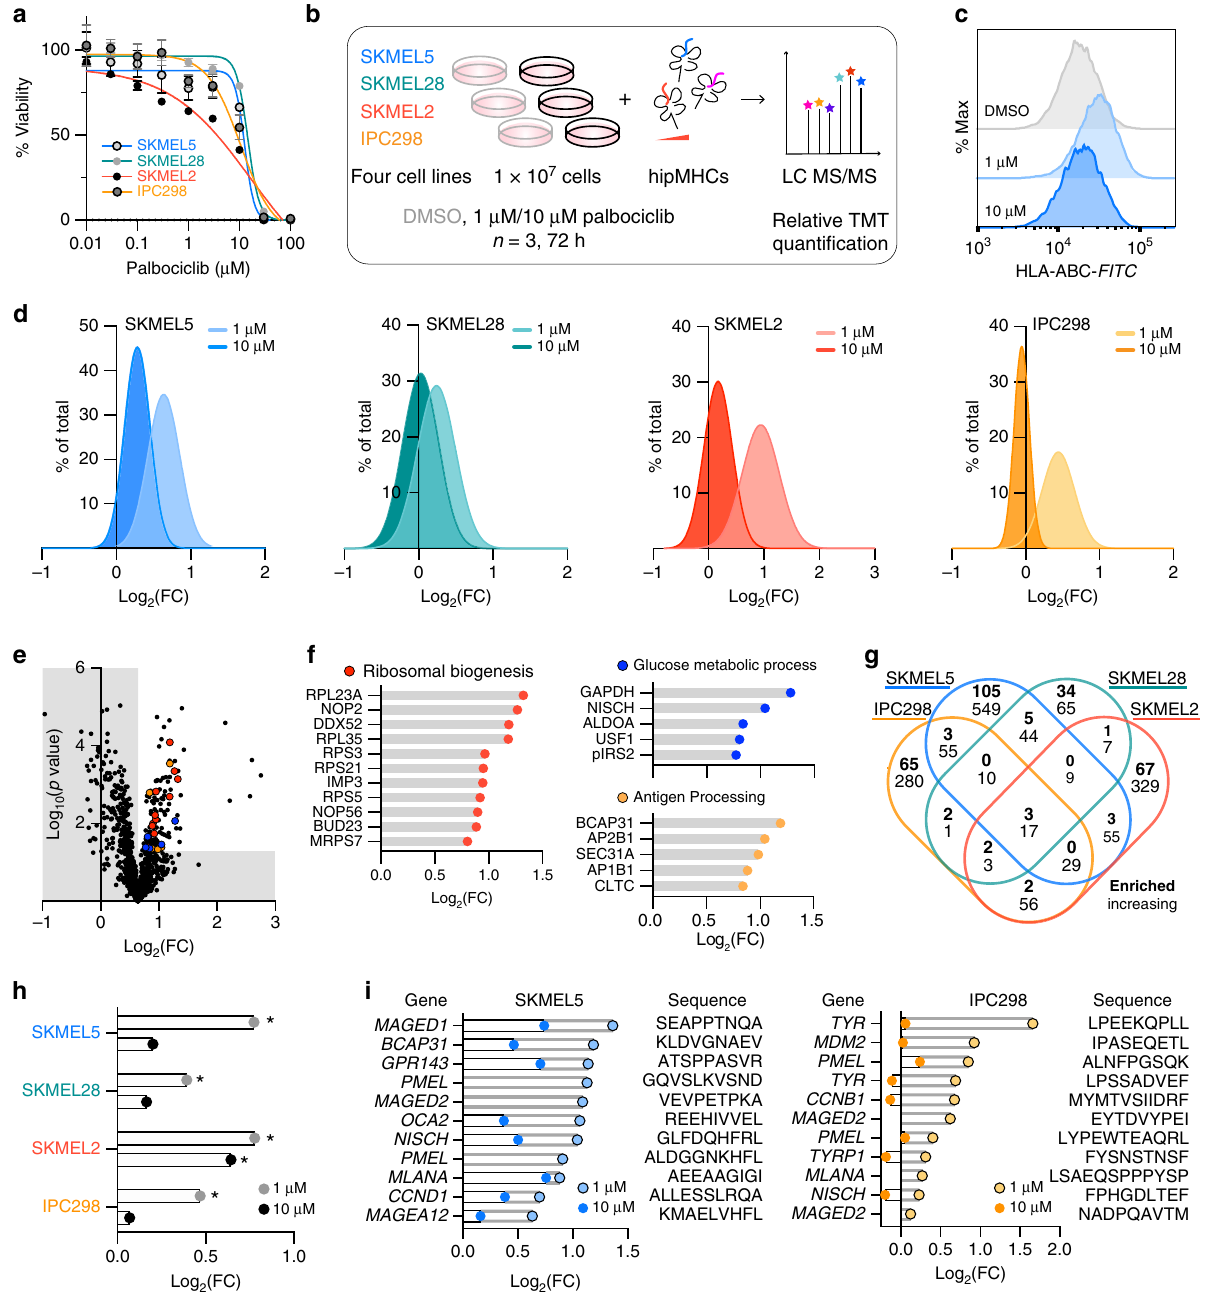
Fig. 4 Palbociclib alters the immunopeptidome in melanoma. a Viability at 72 h after drug treatment; data are represented as a fraction (%) of the DMSO control. Calculated IC 50 s: SKMEL5 = 12.74 μ M, SKMEL28 = 14.62 μ M, SKMEL2 = 16.98 μ M, and IPC298 = 10.62 μ M. Data are presented as mean values ± SD for n = 3 experimental replicates for all cell lines, except SKMEL5 ( n = 4). b Experimental setup of TMT-labeled immunopeptidomics experiments in melanoma cell lines. c Flow cytometry measurements of surface HLA expression in SKMEL5 cells. Data are represented as % of maximum signal, and the distributions are representative of three independent experiments. d Histogram distribution of log 2 fold change (FC) of (palbociclib/DMSO) for unique pMHCs, where FC is calculated from the mean intensity of n = 3 biological replicates per condition. Data are represented as a % of total unique peptides identi fi ed. e Volcano plot displaying log 2 (FC) of 1 μ M treated SKMEL5 cells versus signi fi cance (mean-adjusted p value, unpaired two-sided t test).